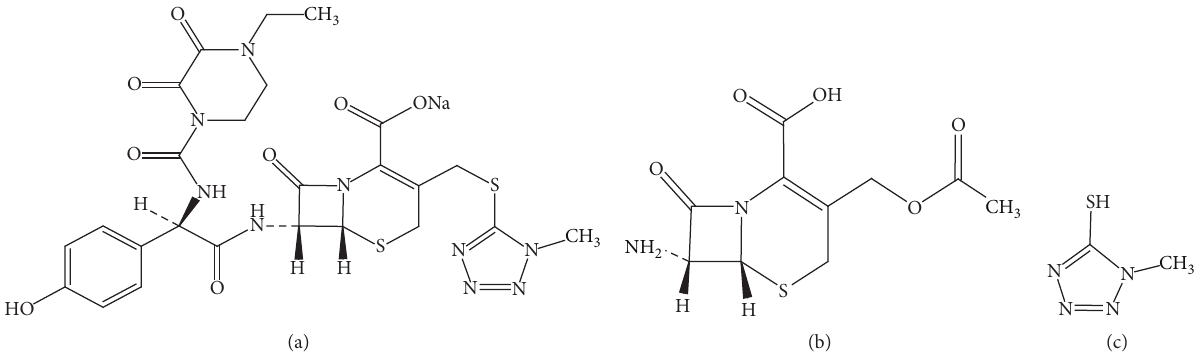
Figure 1: Chemical structures of CEF (a) and its reported impurities 7-ACA (b) and 5-MER (c).